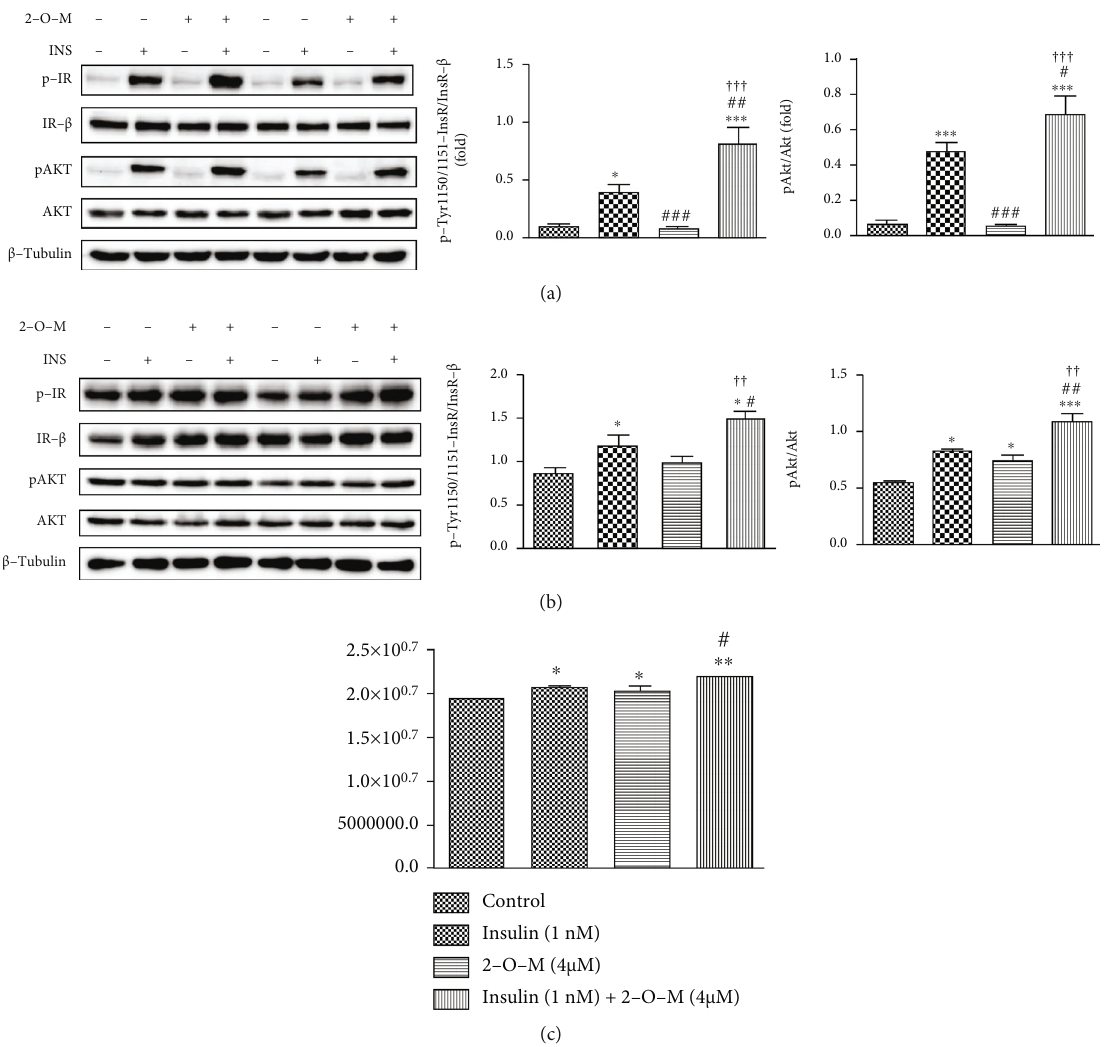
Figure 2: The combination of 2 ′ -O-methylperlatolic acid (2-O-M) and insulin activates the insulin signaling pathway and stimulates cellular sugar uptake. (a) Expression of key proteins of the insulin signaling pathway in di ff erent groups of 2-O-M and insulin in Hepa 1-6 cells. (b) The expression of key proteins in the insulin signaling pathway in di ff erent groups of 2-O-M and insulin in C2C12 cells. (c) The e ff ect of 2-O-M combined with insulin on glucose uptake capacity in C2C12 cells. Data are shown as the mean ± SEM ( n = 6/7 in each group). ∗ p < 0 : 05 ; ∗∗ p < 0 : 01 ; ∗∗∗ p < 0 : 001 versus control. # p < 0 : 05 ; ## p < 0 : 01 ; ### p < 0 : 001 versus insulin. † p < 0 : 05 ; †† p < 0 : 01 , 2- O-M versus